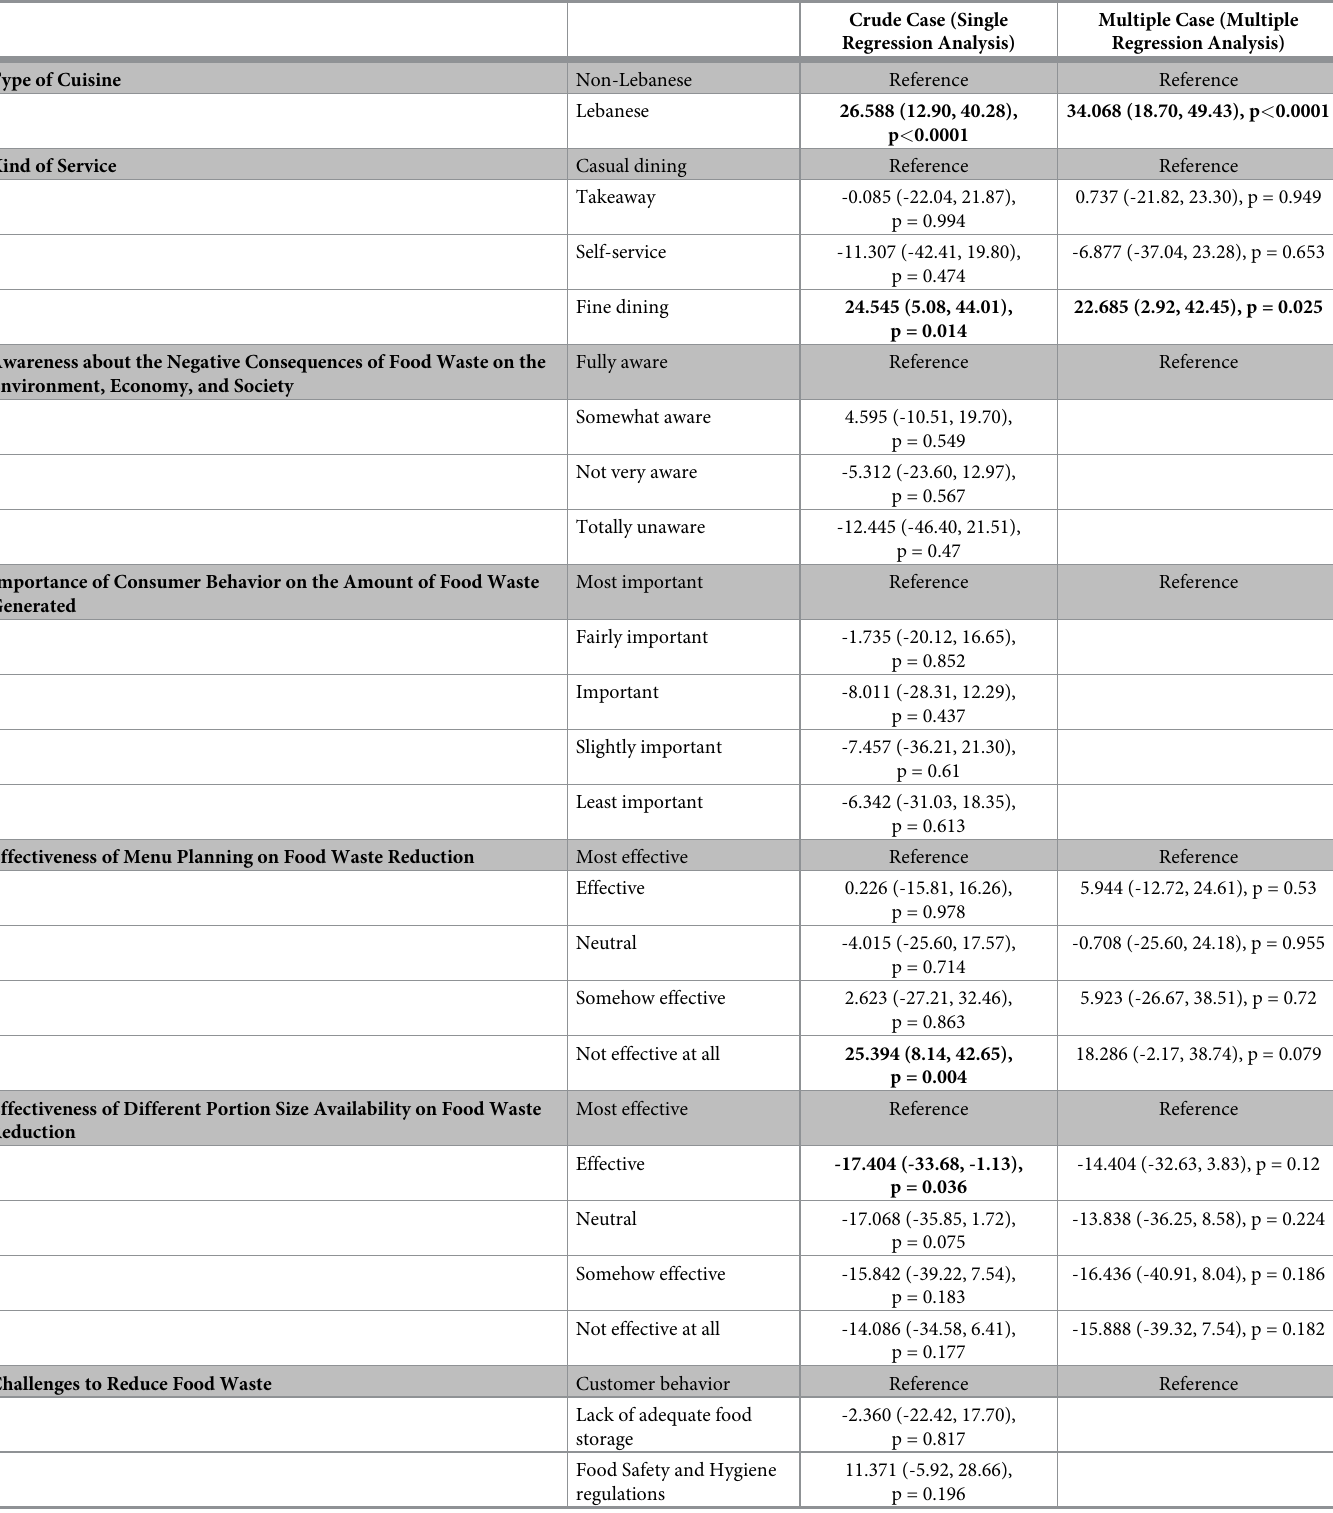
Table 2. Determinants of food waste generation–censored regression